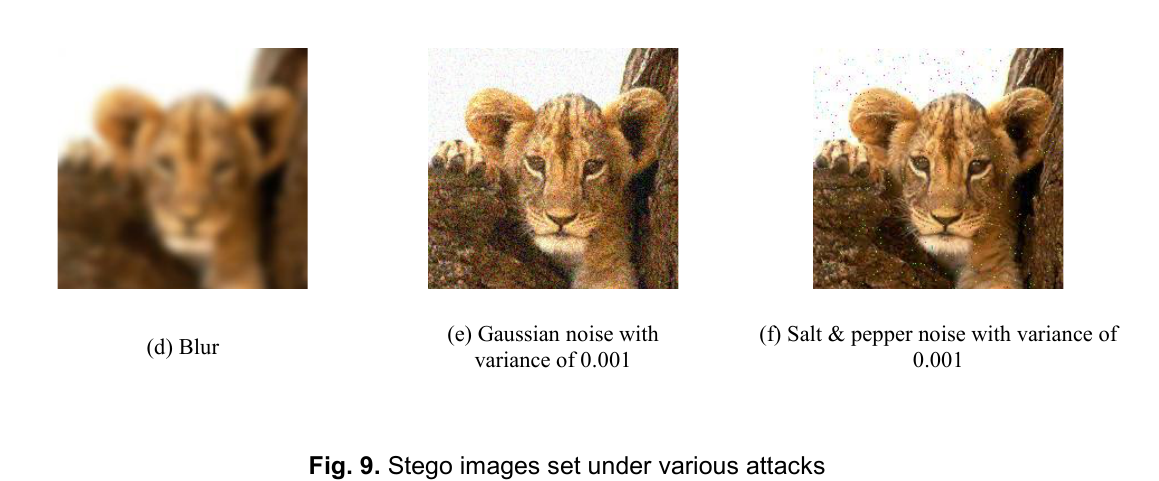
Fig. 9. Stego images set under various attacks